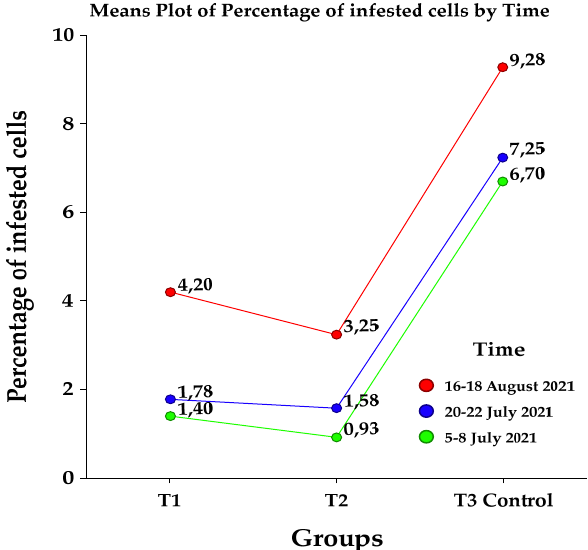
Figure 1. The mean percentage of varroa mite infested cells evaluated in brood at different time intervals, as well as in different experimental groups.